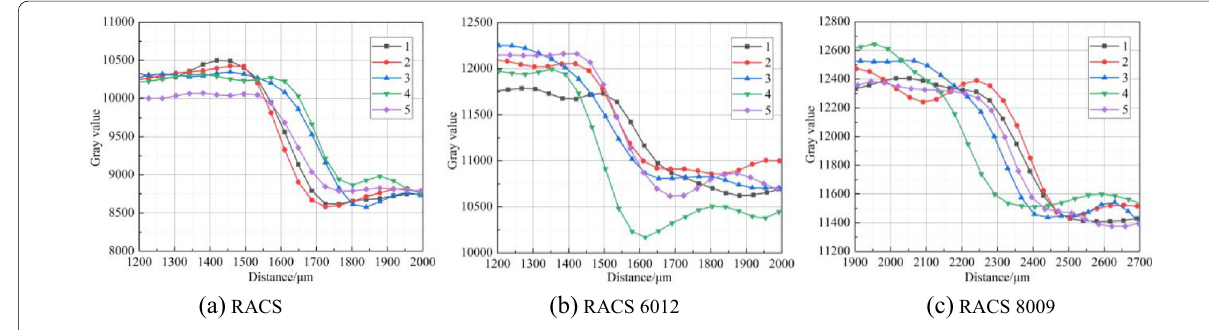
Fig. 20 Gray curve of transition zone between recycled aggregate and old mortar